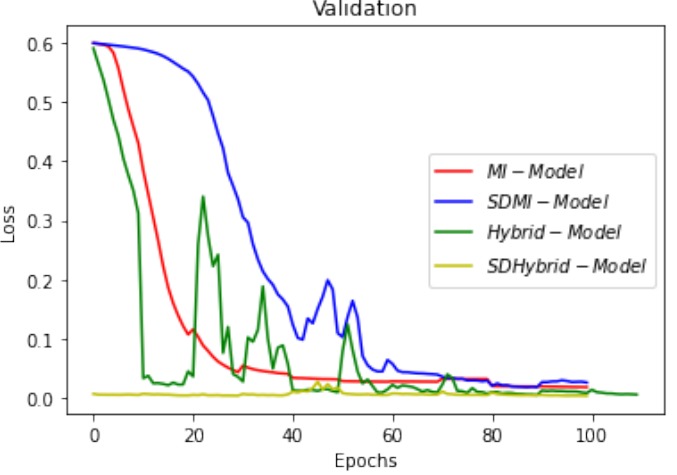
Figure 22. Comparison of Validation Loss.